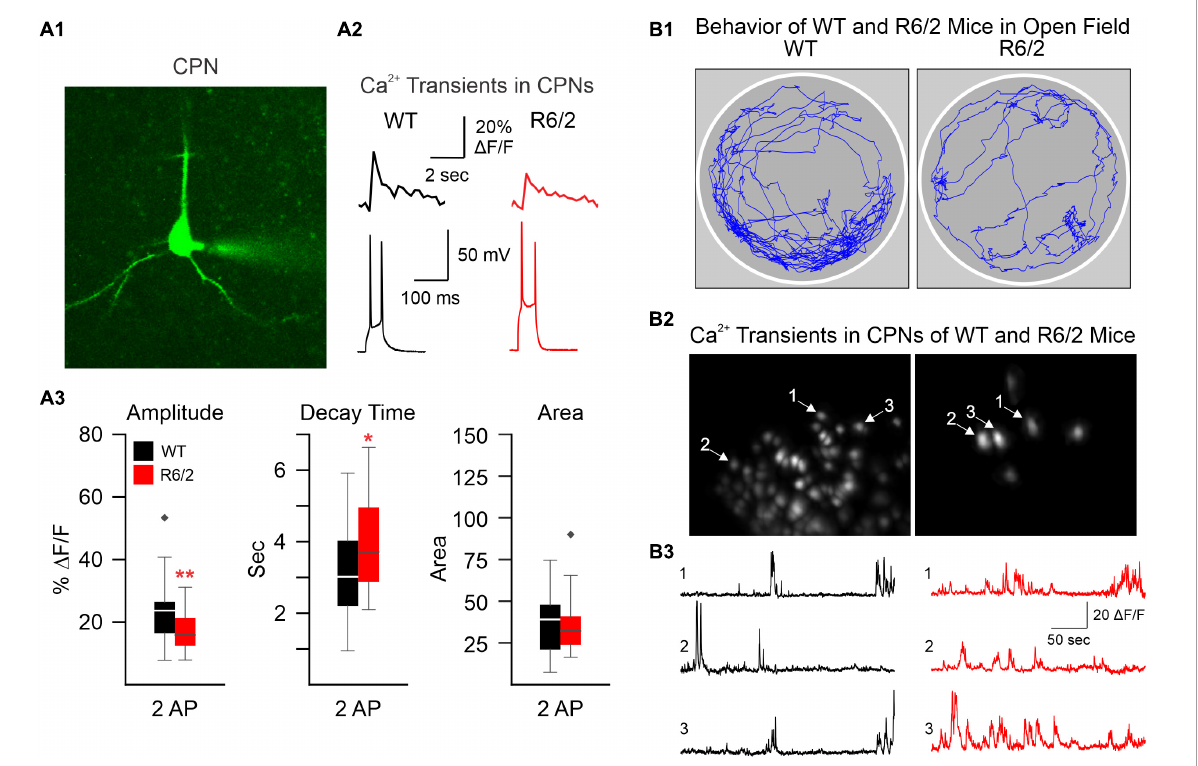
FIGURE1 (A) We used two-photon microscopy to examine Ca 2 + influx induced by action potentials (APs) in layer II cortical pyramidal neurons (CPNs) from R6/2 model mice. (A1) A CPN was patched and filled with a Ca 2 + indicator (OGB-1). (A2) Action potentials (APs) evoked by 50 ms depolarizing current steps from the resting membrane potential. Accompanying Ca 2 + transients are shown above the APs. (A3) The amplitude of somatic Ca 2 + transients was reduced in R6/2 mice compared to controls. This reduction was compensated by increased decay times, which could lead to reduced Ca 2 + buffering capacity [modified from Oikonomou et al. (2021)]. (B) A miniscope and a video camera above a cylindrical arena were used to visualize Ca 2 + transient activity and behavior of WT and R6/2 mice. (B1) Movement tracking during 5 min behavior video recording. Notice the sparsity of movement in the symptomatic R6/2 mouse. (B2) Images of fluorescent CPNs in layer V of the same WT and symptomatic R6/2 mice. (B3) Ca 2 + transients from three selected CPNs shown in B2 . * p < 0 . 05, ** p < 0 . 01, and black diamonds are outliers for the box and whisker